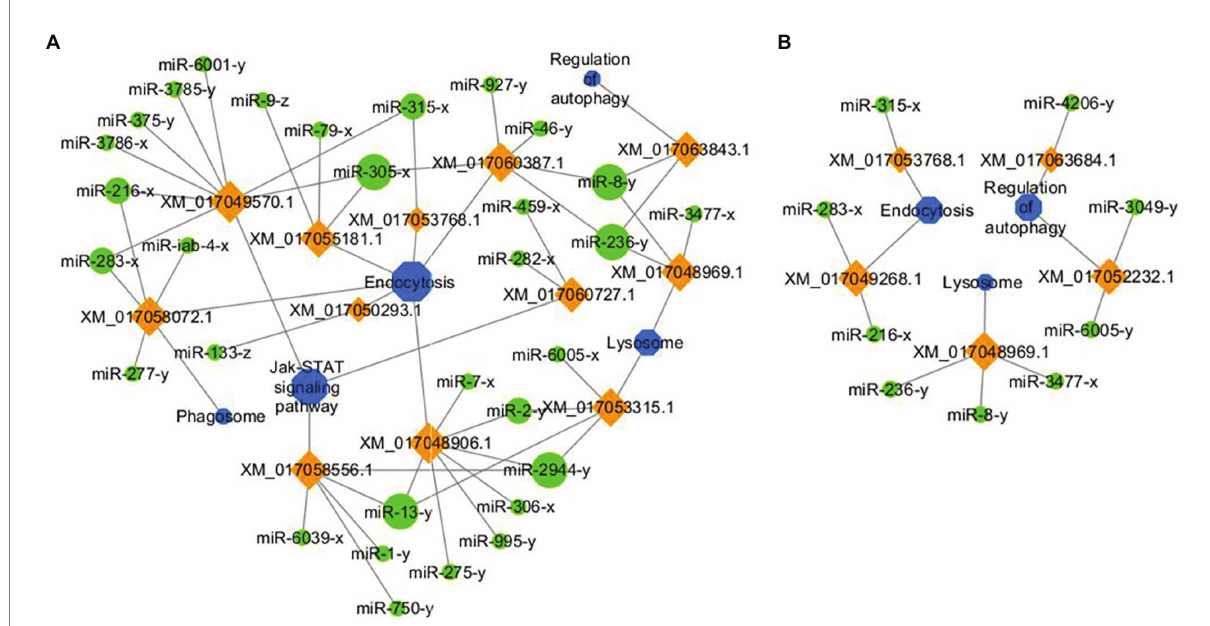
FIGURE 9 Regulatory networks of N. ceranae DEmiRNAs and their target DEmRNAs associated with A. c. cerana immune-related pathways. (A) Network of up-regulated miRNAs in NcCKmi vs. NcTmi7 and immune-associated down-regulated mRNAs in AcCKm7 vs. AcTm7. (B) Network of up-regulated miRNAs in NcCKmi vs. NcTmi10 and immune-associated down-regulated mRNAs in AcCKm10 vs.